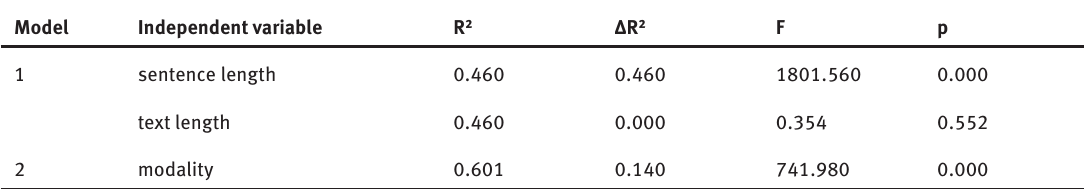
Table 3: Hierarchical multiple regression analyses of the effects of modality on DD